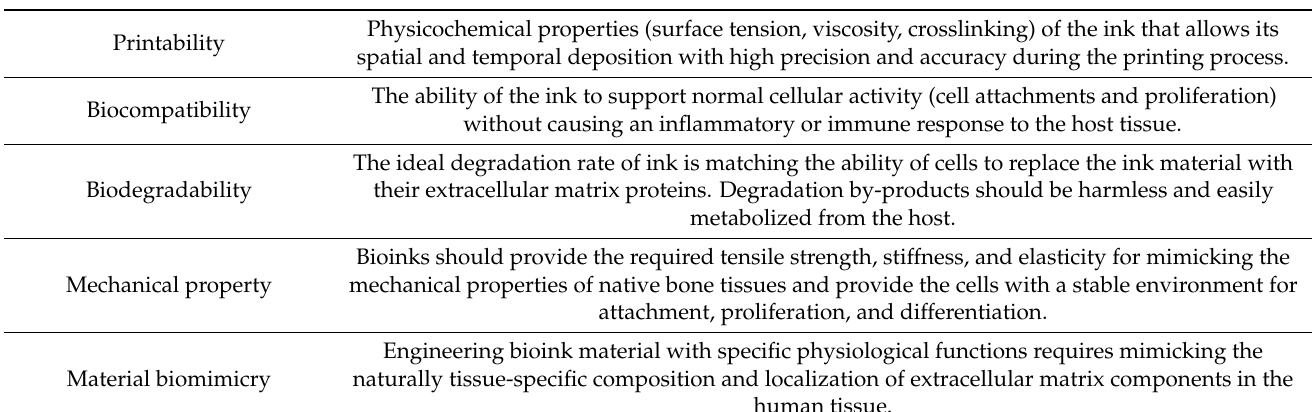
Table 4. Ink features for 3D bioprinting of human tissue. Table modified with permission from reference [12].